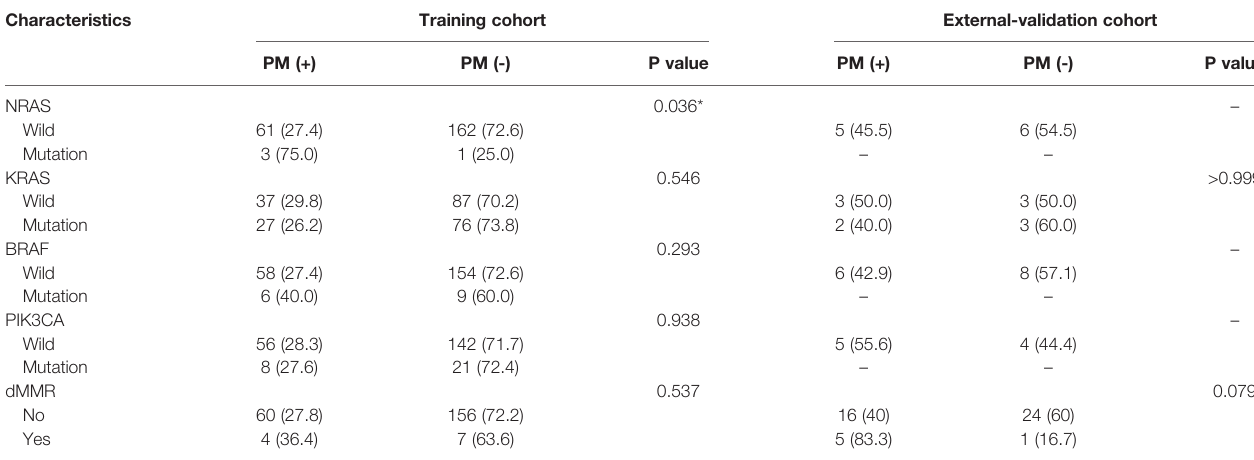
TABLE 2 | Demographics of NRAS, KRAS, BRAF, PIK3CA and dMMR status. Characteristics